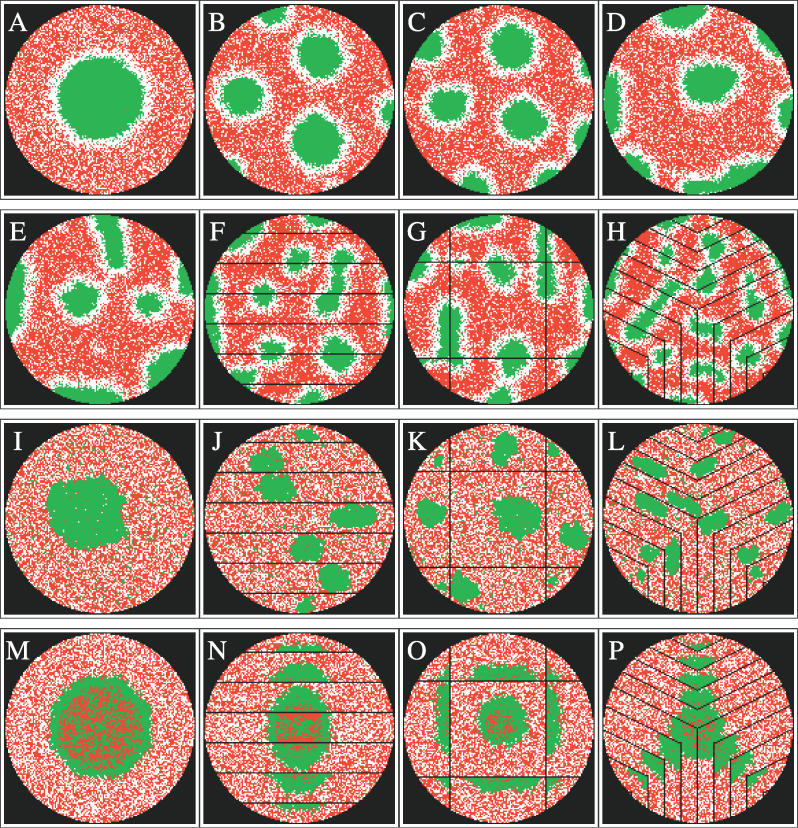
IS Pattern Formation Composed of TCR–pMHC Complexes (Green) and LFA-1–ICAM-1C Complexes (Red) with Various Interaction Mechanisms Being Changed in a Stepwise Manner(A–D) Same parameters as in Figure 2A–2D for varying attraction length: (A) Latt = R, (B) Latt = 0.43R, (C) Latt = 0.29R, and (D) Latt = 0.15R.(E–H) Same parameters as in Figure 2A–2D in the absence of long-range attraction (watt = 0) for the geometrically repatterned ISs.(I–L) IS pattern formation in the absence of long-range attraction between TCR–pMHCs (watt = 0) and short-range repulsion between TCR–pMHC and LFA-1–ICAM-1 (wrep = 0), and with strong TCR–pMHC adhesion: α = 5.(M–P) Same parameters as in Figure 2A–2D in the absence of short-range repulsion (wrep = 0).